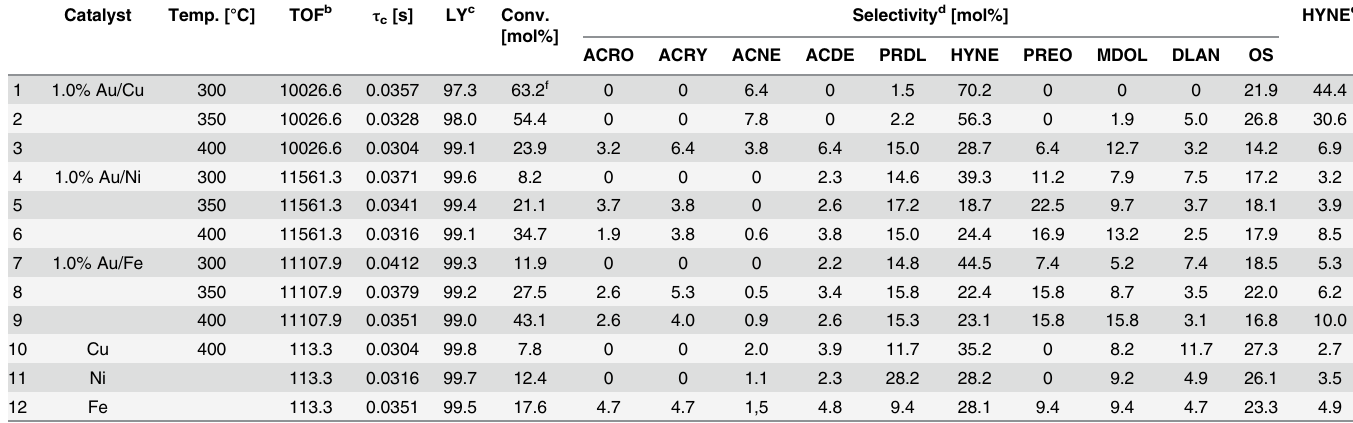
Table 4. Catalytic performance of Cu-, Ni- and Fe-supported Au NPs in undiluted glycerol solutions at 300 – 400°C a . Catalyst